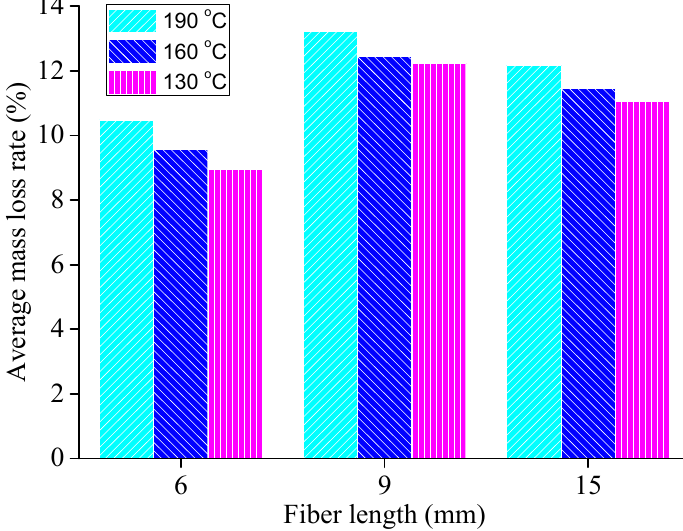
Figure 12. Mass loss rate for fiber-reinforced asphalt binder at different temperatures.